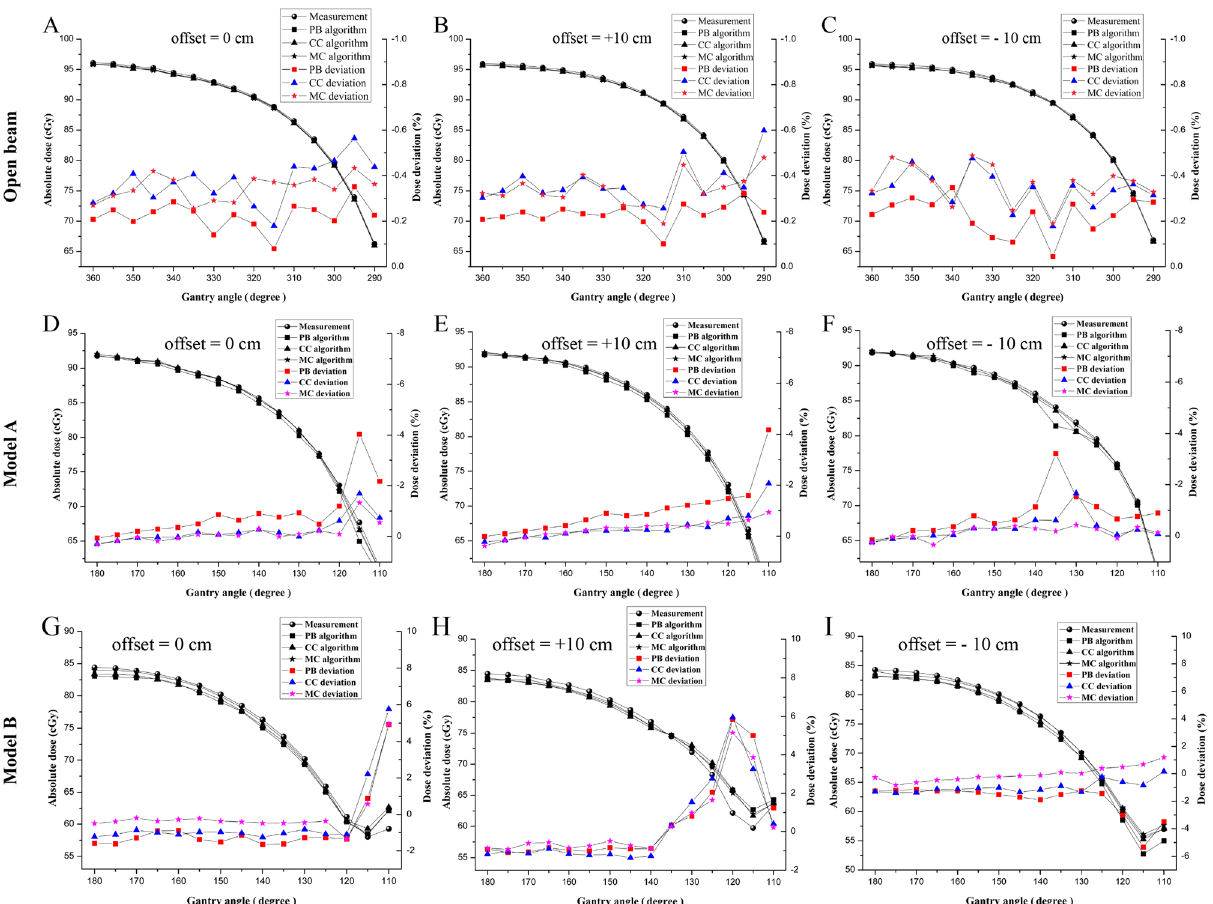
Figure 6. The diagrams illustrating the dose deviations between TPS calculation with three different algorithms and actual measured isocenter dose at different positions for model ( A ) and model ( B ). ( A )–( C ) The dose deviation for the open beam irradiation in model A with different positions, offset = 0 ( A ), offset = + 10 cm ( B ), and offset = − 10 cm ( C ); ( D )–( F ) The dose deviation for irradiation with couch passing through in model ( A ) with different positions, offset = 0 ( D ), offset = + 10 cm ( E ), and offset = − 10 cm ( F ); ( G )–( I ) The dose deviation for irradiation with dummy couch structure inserted in model ( B ) with different positions, offset = 0 ( G ), offset = + 10 cm ( H ), and offset = − 10 cm ( I